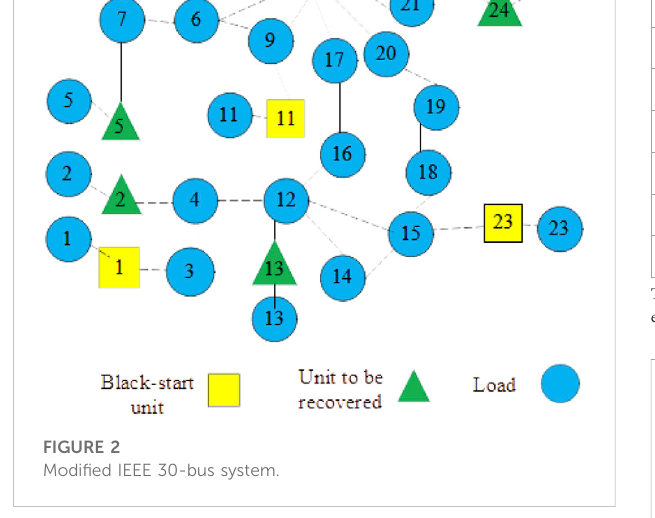
FIGURE 2 Modi fi ed IEEE 30-bus system.